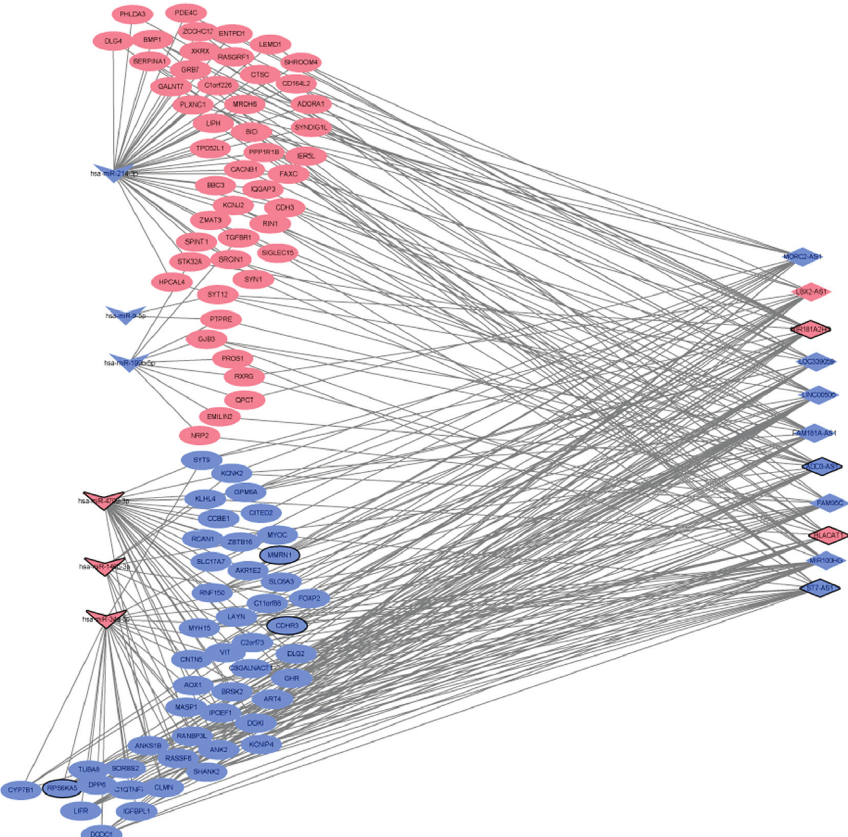
Figure 6: The ceRNA network of diagnostic lncRNA-common mRNA-diagnostic miRNA in PTC after taking the intersection of the interaction network of diagnostic lncRNA-co-expressed mRNA and diagnostic miRNA-mRNA pairs. The rhombus, rectangle, and ellipse represent the diagnostic lncRNAs, diagnostic miRNAs, and mRNAs, respectively; the pink and blue colors represent upregulation and downregulation, respectively; the black border represents the top 10 upregulated and top 10 downregulated